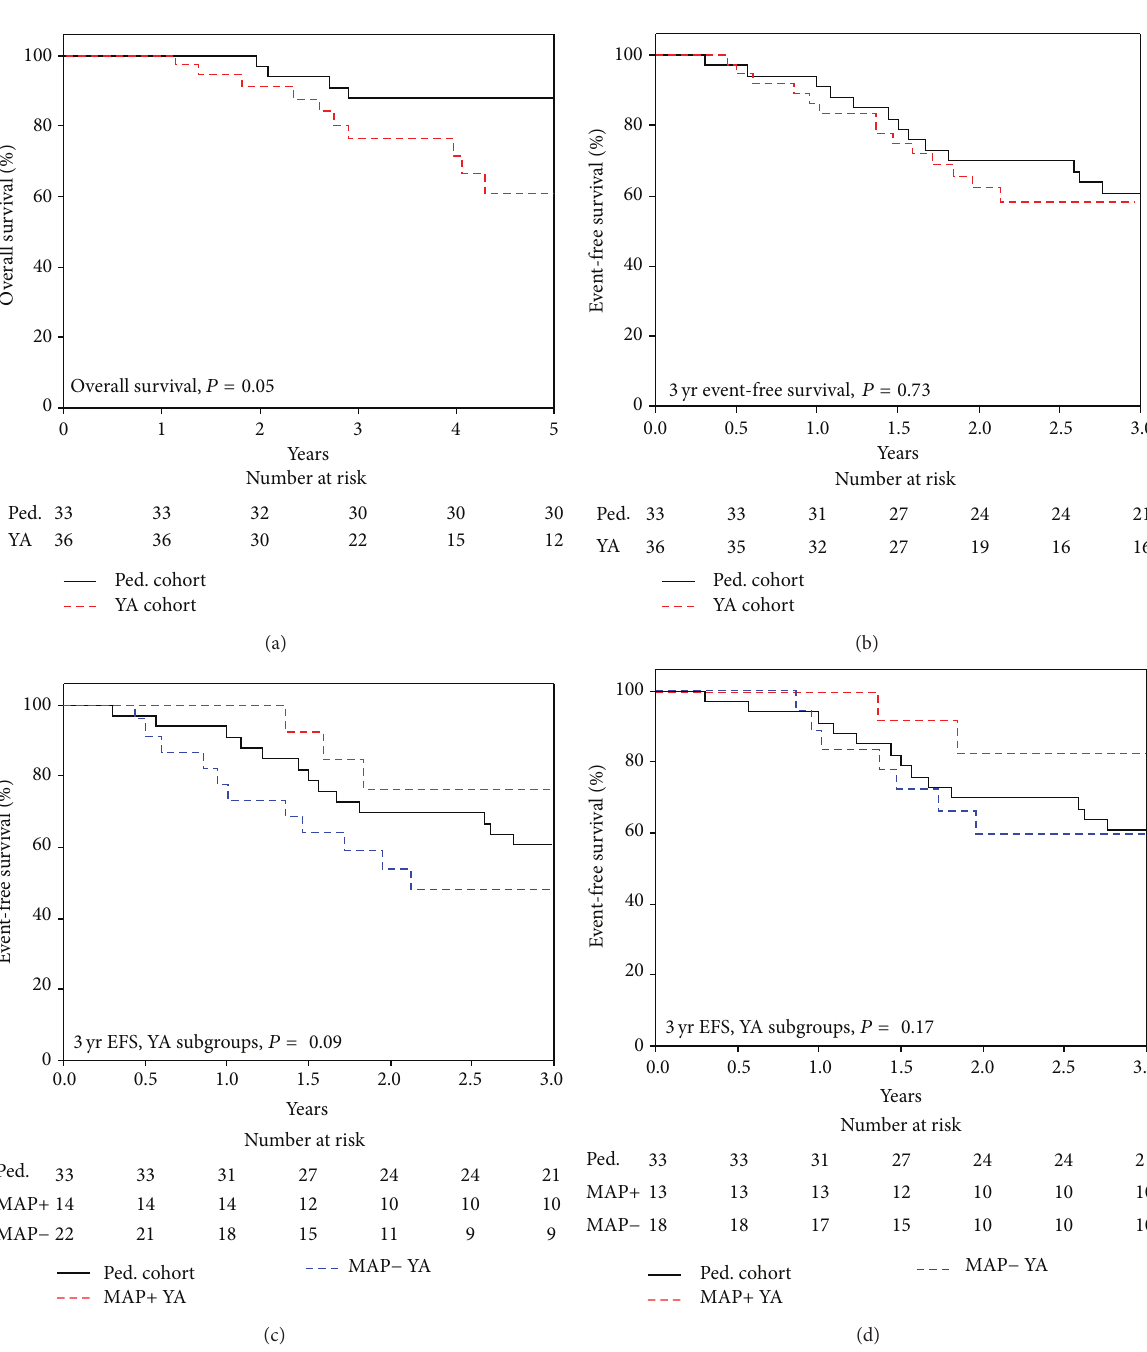
Figure 3: Localized disease outcomes for pediatric and YA cohorts demonstrate better overall survival in pediatric cohort and improved 3-year EFS for MAP+ YA patients. (a) Five-year overall survival of patients with localized disease in the pediatric and YA cohort ( 𝑃 = 0.05 ). (b) Three-year EFS for pediatric cohort and YA cohort ( 𝑃 = 0.73 ). (c) Three-year EFS of YA patients who received less chemotherapy than the typical pediatric regimen (MAP − ) compared to YA patients who received the typical pediatric regimen (MAP+) ( 𝑃 = 0.09 ). (d) Three- year EFS of YA MAP − patients compared to YA MAP+ patients. Patients who had recurrence during primary MAP therapy were removed ( 𝑃 = 0.17